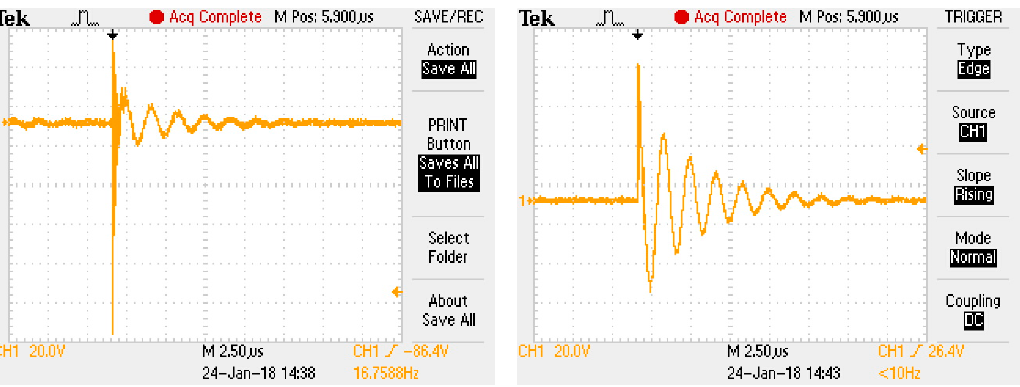
Figure 17. PD signal without filter ( left ); PD signal with filter ( right ).